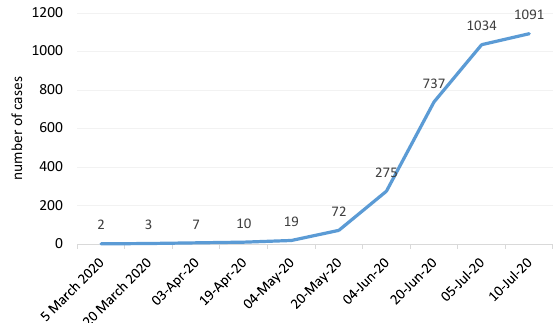
Figure 1 . Cumulative Frequency of COVID-19 Infection.